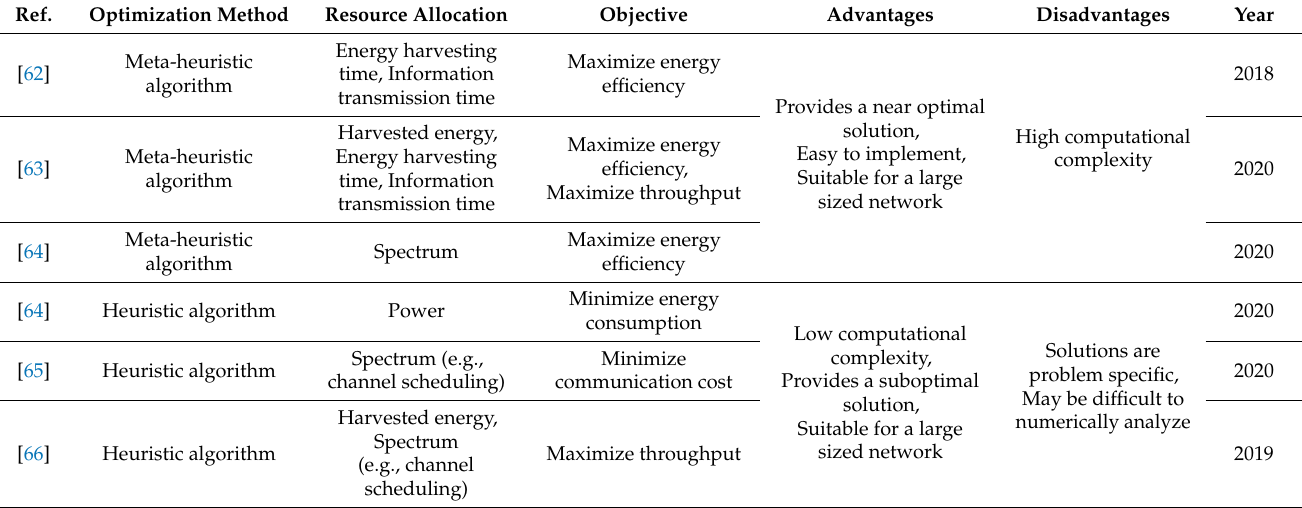
Table 1. Summary of resource management solutions based on optimization